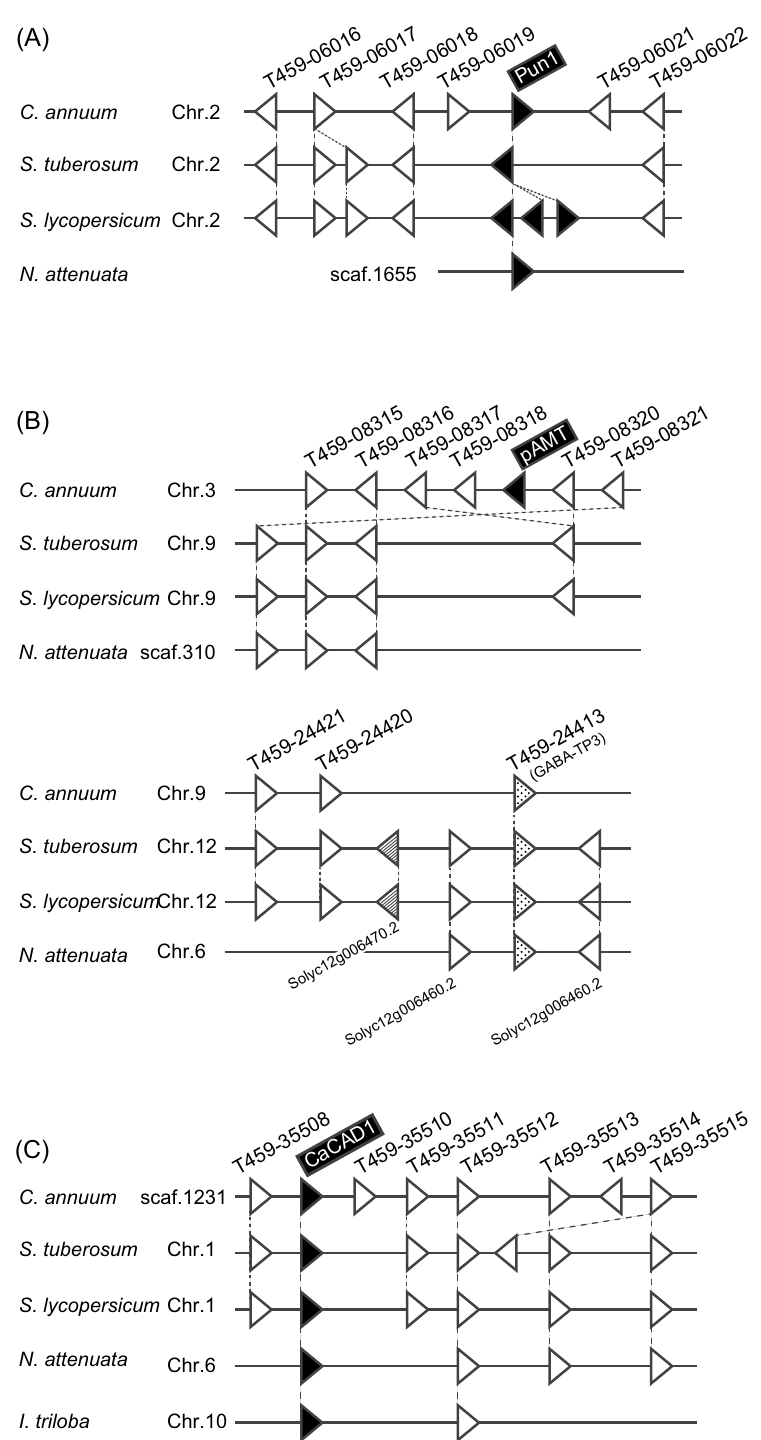
Figure 7. Syntenic analyses of C. annuum, S. tuberosum , S. lycopersicum, N. attenuata , and I. triloba genes . ( A ) Synteny around Pun1 . Black triangles indicate Pun1 and orthologous genes ( S. tuberosum : PGSC0003DMG400007310; S. lycopersicum : Solyc02g081740.2, Solyc02g081745.2, and Solyc02g081760.2; N. attenuata : ASAT3_8). ( B ) Synteny around pAMT and homologous genes. The black triangle indicates pAMT , whereas dotted and diagonal patterned triangles indicate homologous genes. ( C ) Synteny around CaCAD1 . Black triangles indicate CaCAD1 and orthologous genes ( S. tuberosum : PGSC0003DMG401025767; S. lycopersicum : Solyc01g107590; N. attenuata : CAD19; I. triloba : itb10g24120). Distances between intergenic regions and gene coding regions are arbitrary. Gene names on the top and bottom are from the C. annuum and S. lycopersicum genomes,